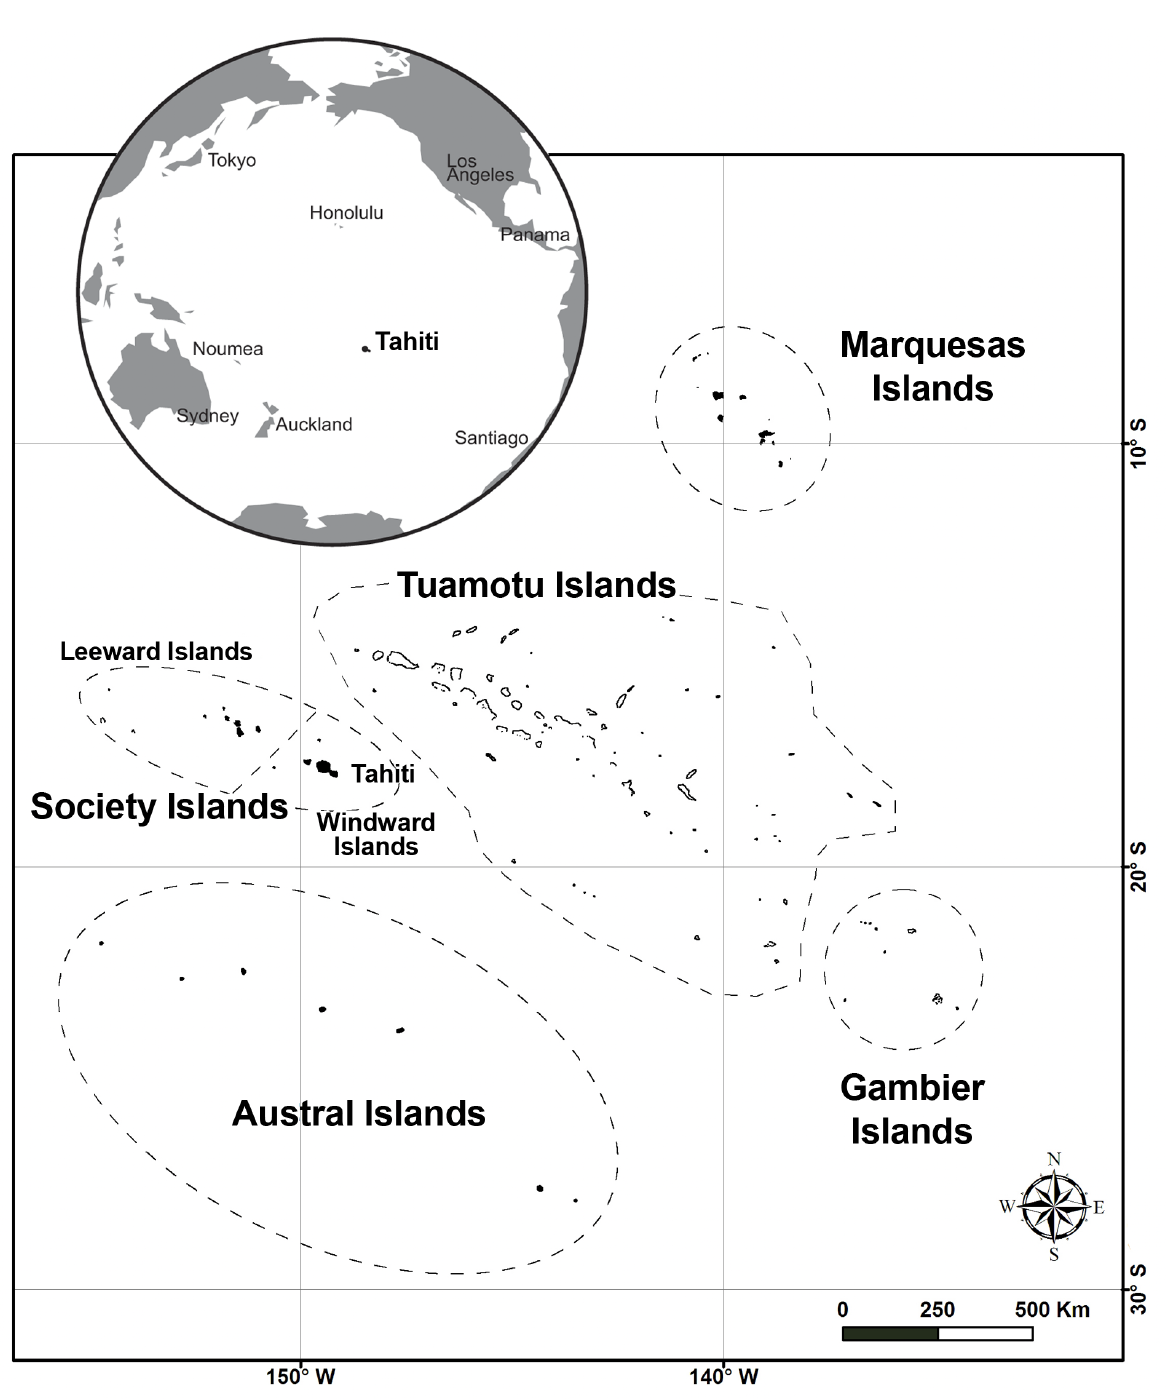
Fig. 1. Map of French Polynesia (from Fred Jacq; modified with globe from Rouzé et al . 2017). ( https://doi.org/10.7717/peerj.2856/fig-1